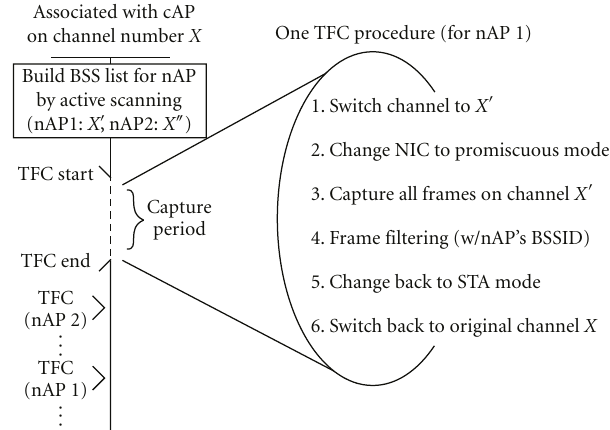
Figure 2: Transient frame